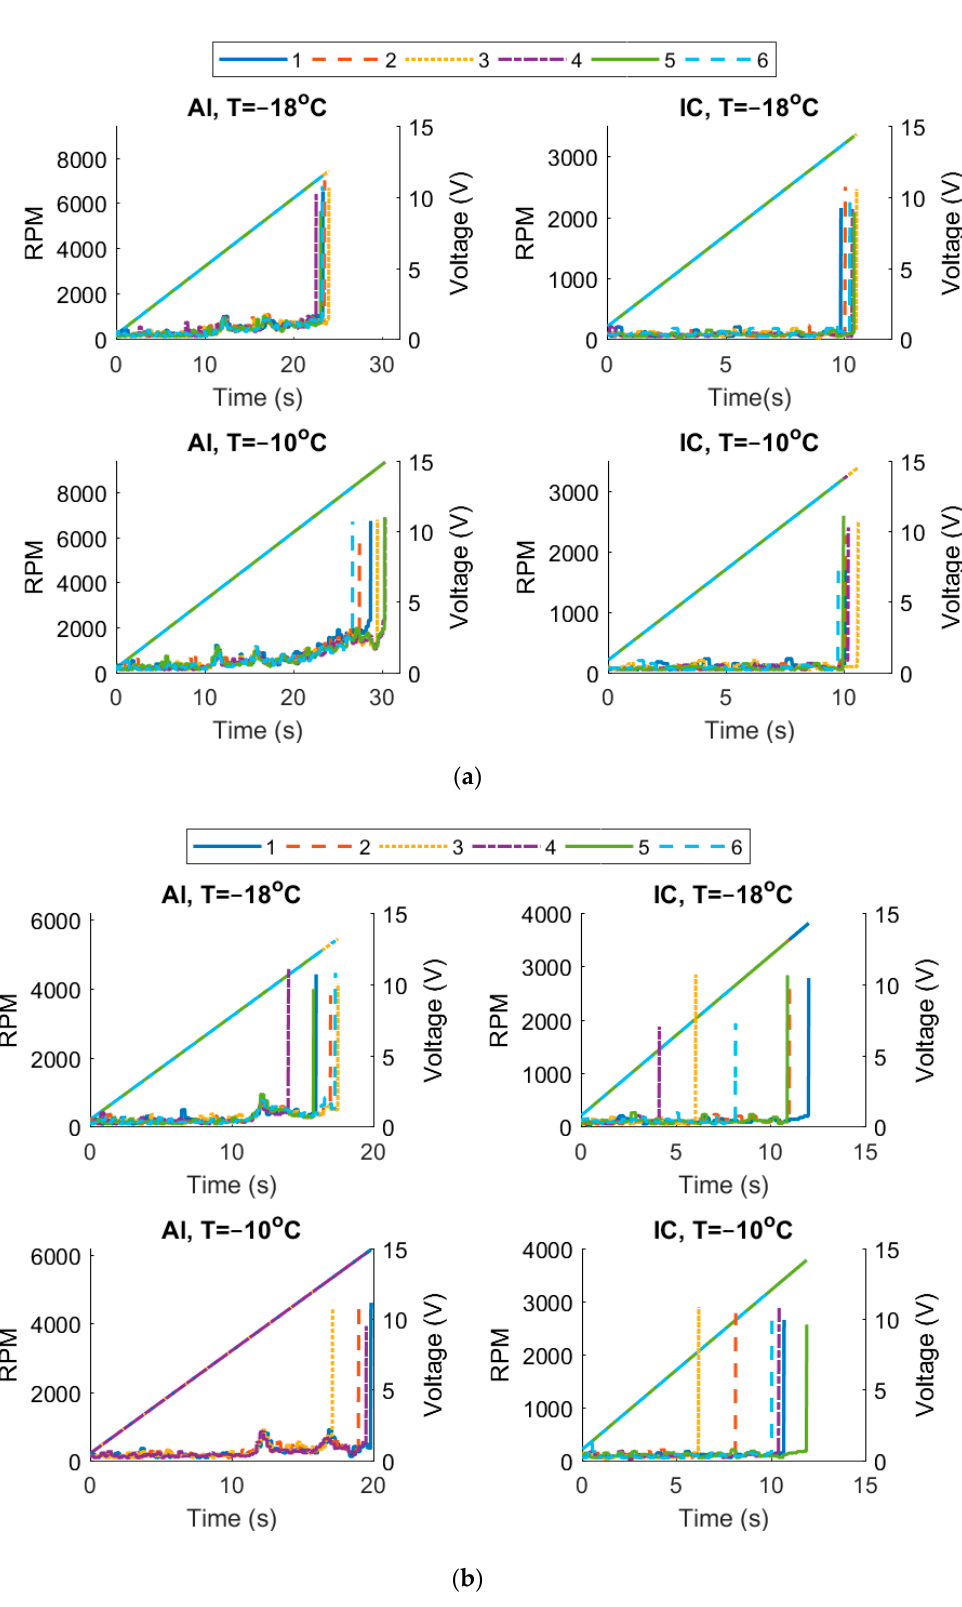
Figure 5. Rounds per minute (RPM)-time curves for CAT measured at AMIL for both ice types. The left axis denotes the RPM, which increases with constant acceleration, and the right axis displays the voltage measured by the piezoelectric cells. The end RPM was utilized to calculate the ice adhesion strength as described elsewhere [52], and can be deduced by the placement of the piezoelectric signal for each sample. All six samples for each surface and temperature are indicated, for ( a ) PI and ( b ) BWI.